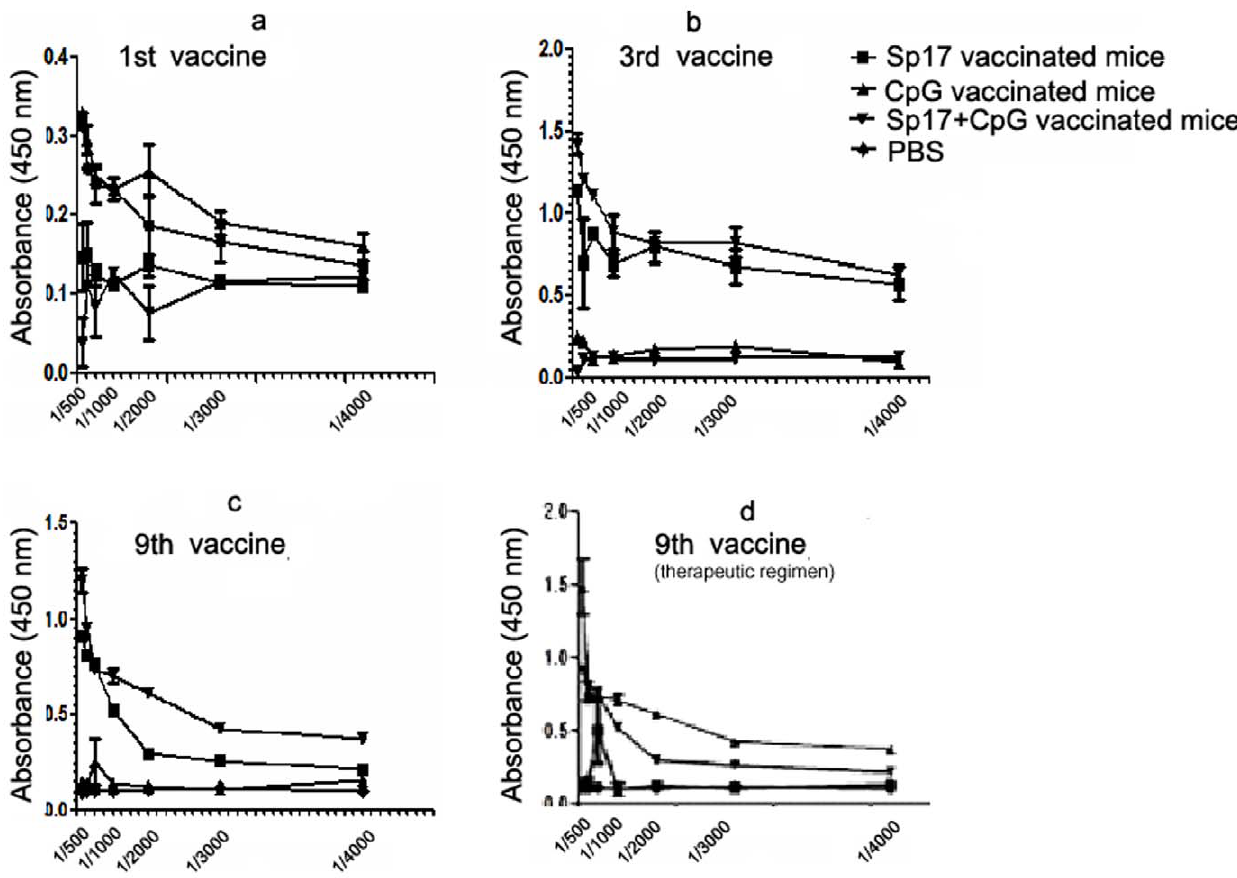
Figure 5. Measurement of circulating anti-Sp17 IgG following different vaccinations. Serum from mice undergone different treatments was collected and analyzed by E.L.I.S.A. for the levels of circulating anti-Sp17 IgG. The X axis shows serial dilutions of serum. a, b and c show results obtained in the prophylactic vaccination schemes, while d displays the response of mice from the therapeutic regimen. On day 7 ( a ) the immune response was low for Sp17. On day 97 ( b ), the immune response was higher than on day 7. On day 270 ( c ), the response for Sp17 was little less than on day 97.